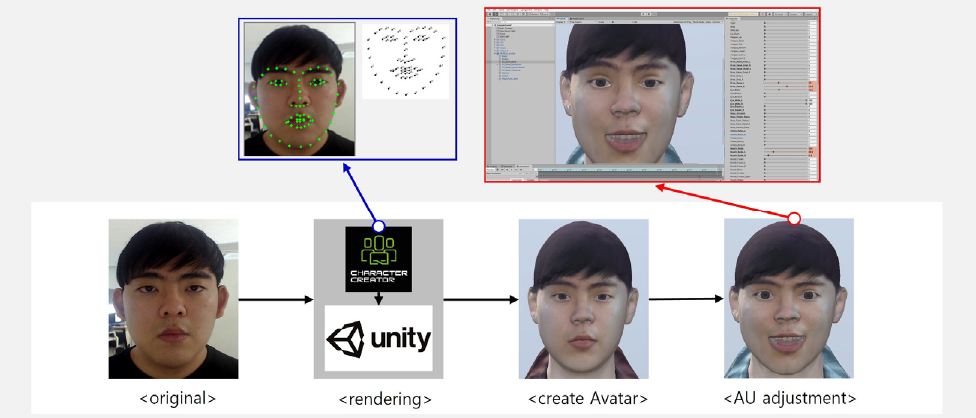
Figure 2. The process of creating a standardized facial expression avatar.